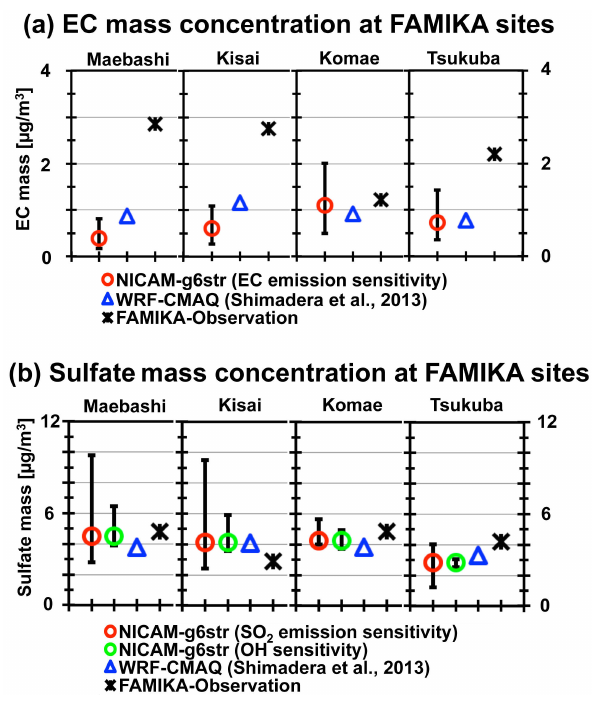
Figure 16. (a) EC and (b) sulfate mass concentrations at the four FAMIKA sites using NICAM-g6str under the sensitivity experi- ments, WRF-CMAQ results shown by Shimadera et al. (2013) and the FAMIKA observations in averages of 6–11 August. The bar rep- resents the range of the